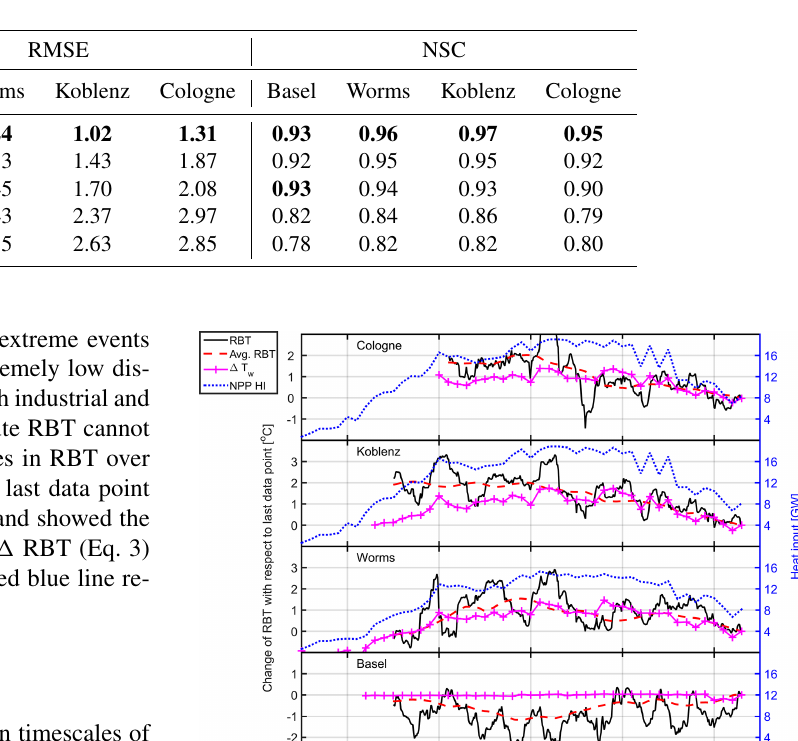
Table 5. RSME (in degrees Celsius) and NSC for all T c calculation methods. Different T c calculation methods and the regressions are applied over the total data set. The RMSE and the NSC are calculated between T w and T w , modelled . The first column contains the calculation method. The best results for each monitoring station and each calculation method are indicated in bold.